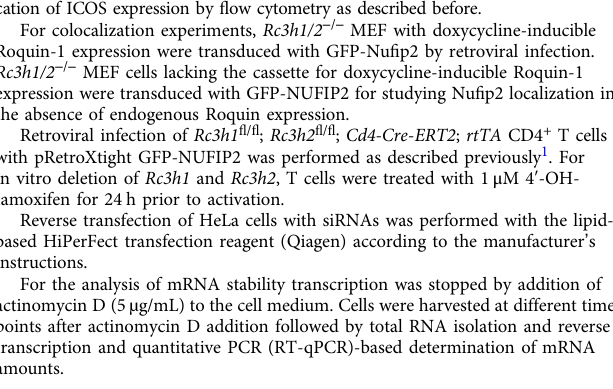
Table 4. Relative gene expression was determined with the Light Cycler 480 SW 1.5.1 software, and normalized to the expression of the reference gene Ywhaz